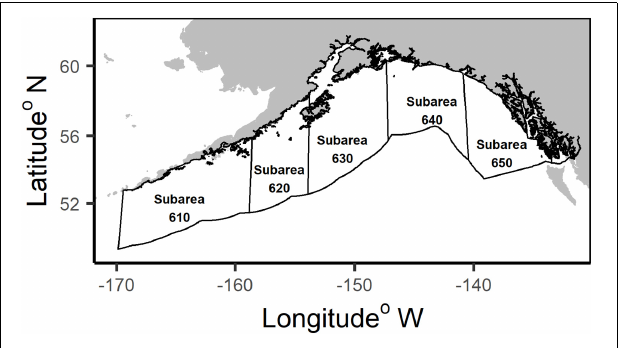
FIGURE 1 | Map of the National Marine Fisheries Service (NMFS) management subareas in the Gulf of